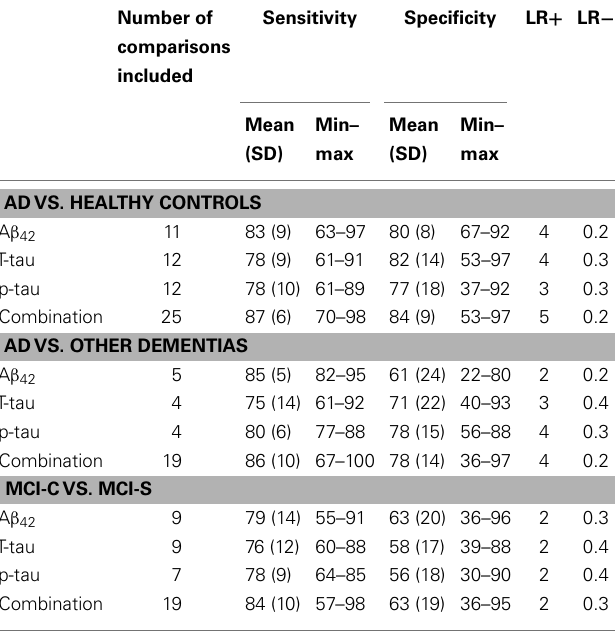
diagnostic criteria: mean sensitivity and specificity